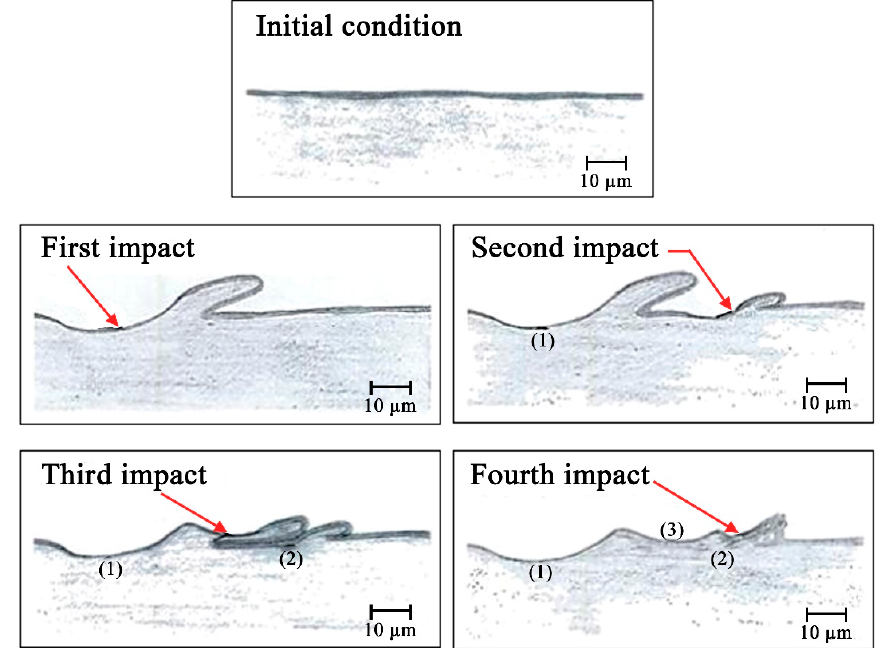
Figure 9. Proposed sequence of SPE of ductile materials. Reproduced with permission from [56]. Elsevier, 1986.